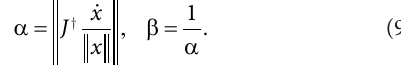
FigUre 6 | The interaction model of the user while interacting with the robot for task execution, the parameters height of the user, distance to the task, and arm lengths are used for later